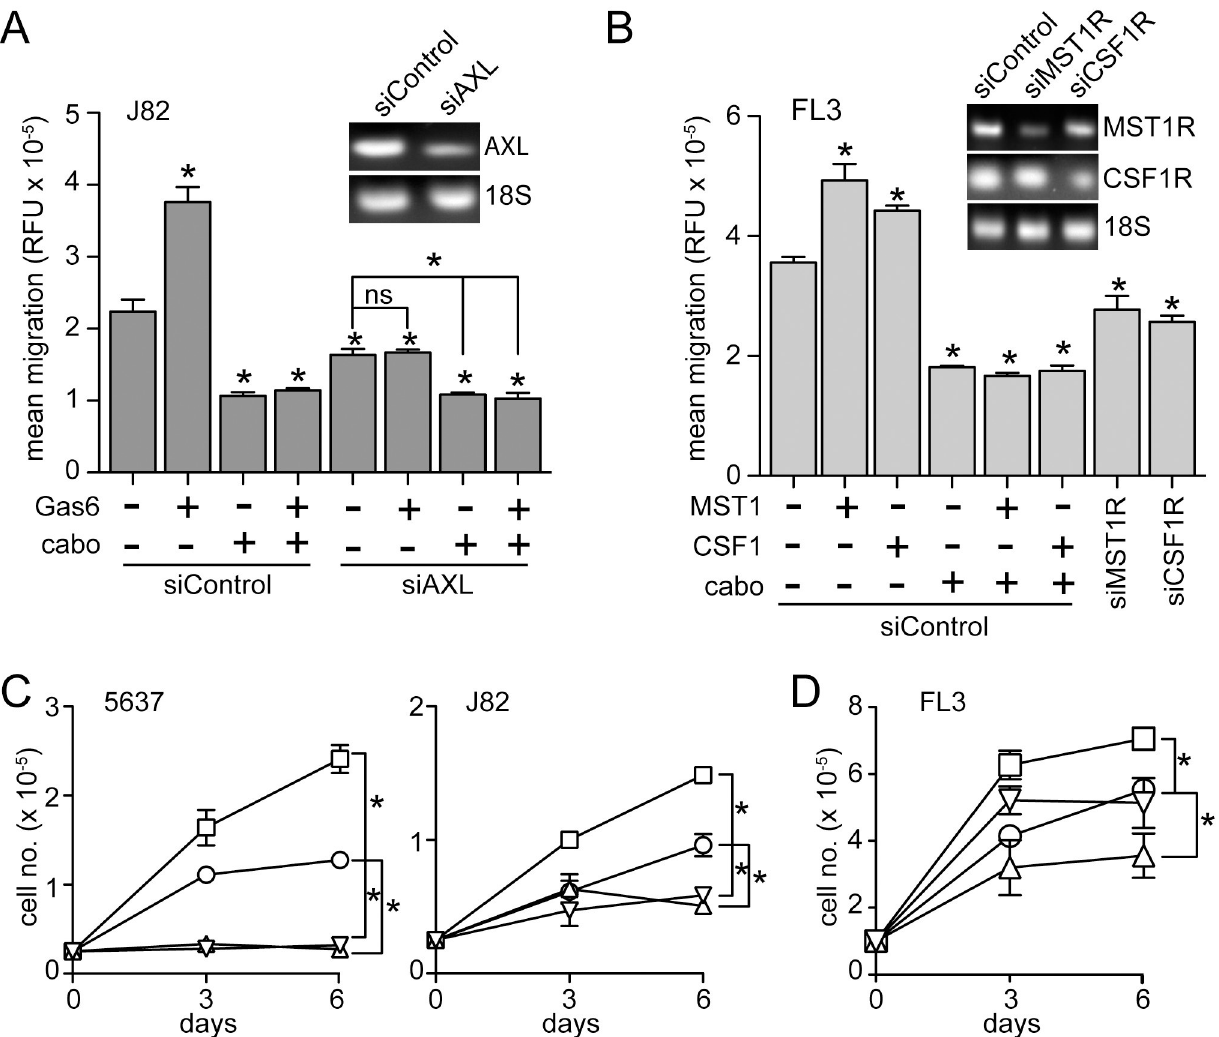
Fig 6. Autocrine RTK driven migration and proliferation in BCa cell lines. (A) Migration (16 h, 37˚C) of serum deprived J82 cells previously transfected with siRNA directed against AXL (siAXL) or control siRNA (siControl), treated with Gas6 (5.7 nM) in the presence or absence of cabozantinib (cabo; 300 nM), relative to untreated cells. Values are the mean +/- SD from triplicate samples; asterisks indicate significant difference from control (p < 0.05; ns, not significant). All results are representative of at least 3 experiments. Inset: ethidium bromide visualization of PCR products specific for AXL mRNA (upper panel) or 18S rRNA (lower panel) resolved by agarose gel electrophoresis. (B) Migration (16 h, 37˚C) of serum deprived FL3 cells previously transfected with siRNA directed against MST1R (siMST1R), CSF1R (siCSF1R) or control siRNA (siControl), treated with MST1 (5 nM) or CSF1 (10 nM) in the presence or absence of cabozantinib (cabo; 300 nM), relative to untreated cells. Values are the mean +/- SD from triplicate samples; asterisks indicate significant difference from untreated control (p < 0.05). All results are representative of at least 3 experiments. Inset: ethidium bromide visualization of PCR products specific for MST1R, (upper panel), CSF1R (middle panel), or 18S RNA (lower panel) resolved by agarose gel electrophoresis. (C) Proliferation (cell no. x 10 − 5 , 6 d, 37˚C) of 5637 (left) or J82 (right) cells in 1% FBS left untreated (control; circles) or treated with Gas6 alone (5.7 nM; squares), cabozantinib alone (300 nM, triangles) or Gas6 and cabozantinib (inverted triangles). Media with additives was replaced on days 1, 2, and 4; cells were counted on days 0, 3 and 6. Values are the mean +/- SD from triplicate samples; asterisks indicate significant difference from control (p < 0.05). (D) Proliferation (cell no. x 10 − 5 , 6 d, 37˚C) of FL3 cells in 1% FBS left untreated (control; circles) or treated with MST1 alone (5 nM; squares), cabozantinib alone (300 nM, triangles) or MST1 and cabozantinib (inverted triangles). Media replacement and cell counting as per panel C. Values are the mean +/- SD from triplicate samples; asterisks indicate significant difference from control (p <